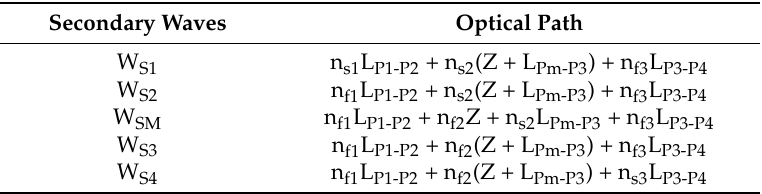
Table 1. Optical path of secondary